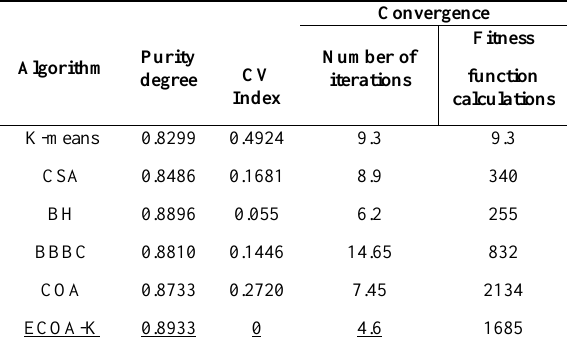
Table 2. Experimental results on iris